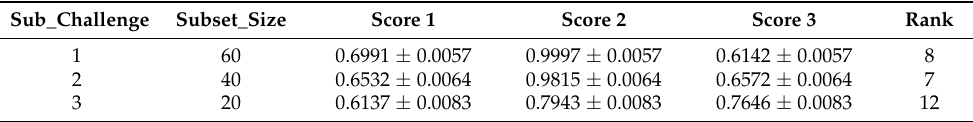
Table 2. Scores and rank for the three challenges by our team in the challenge, using genesets in Table